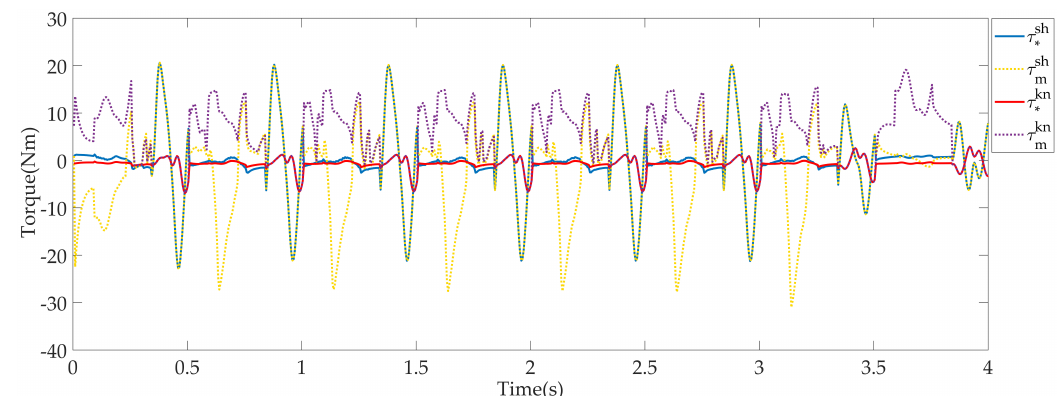
Figure 9. Snapshots of the robot trotting in the simulation.